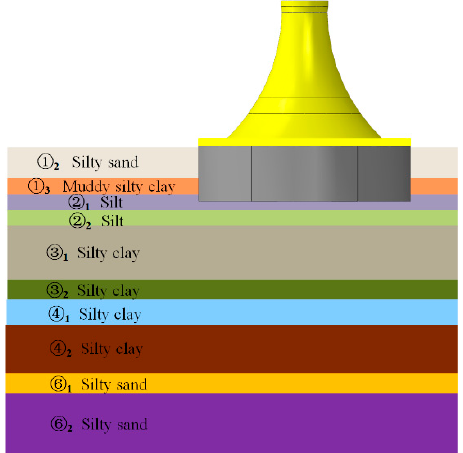
Figure 22. Soil profile parameters and WSBF.